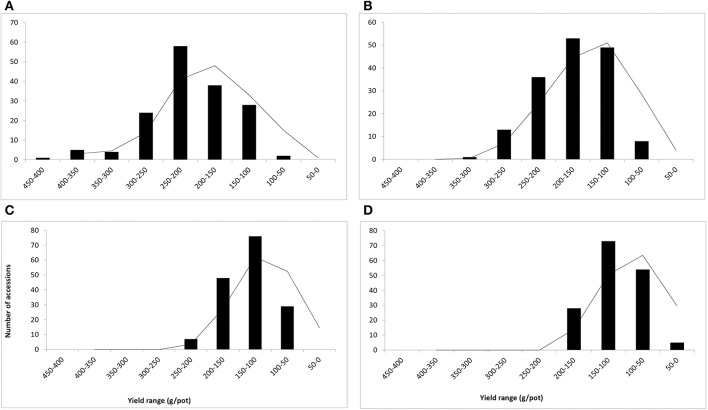
Frequency distribution and yield range (g/pot) of 160 buffelgrass accessions (Means of fresh weight at A–D at heading stage). Whereas, A = 0, B = 10, C = 15, and D = 20 dS m−1 salinity level.